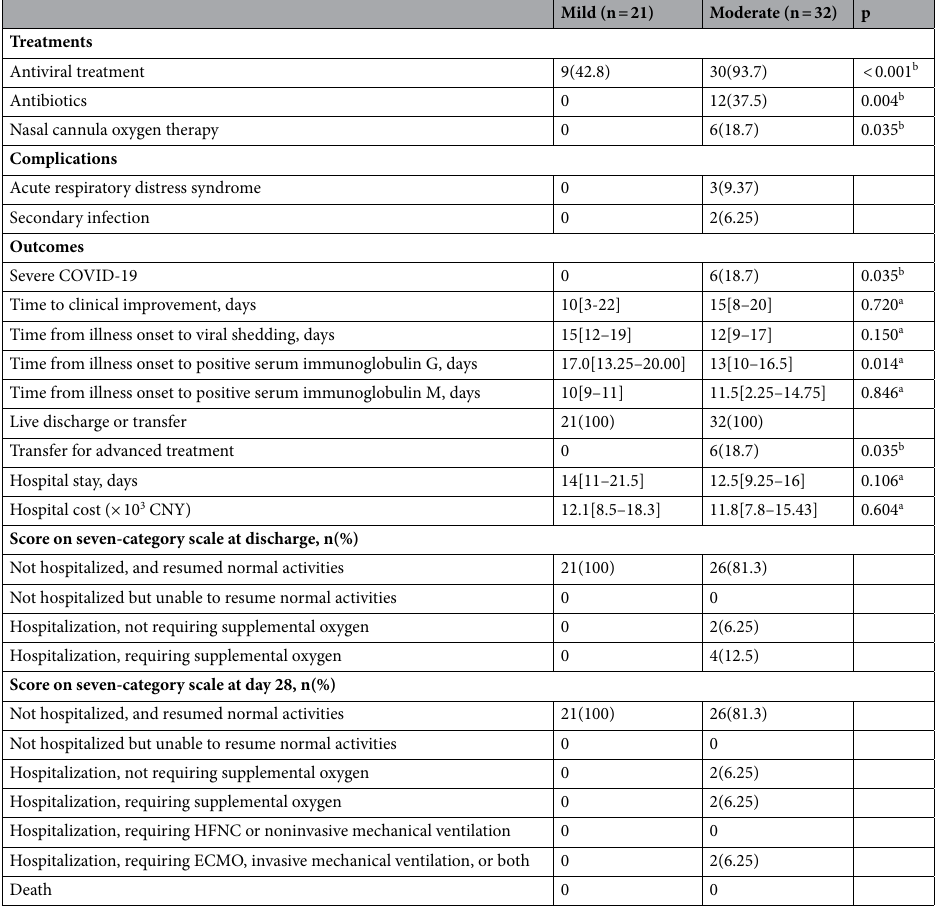
Table 3. Treatments and outcomes of patients with COVID-19. ECMO extracorporeal membrane oxygenation; CNY Chinese Yuan. a p for the Wilcoxon rank sum test. b p for the χ 2